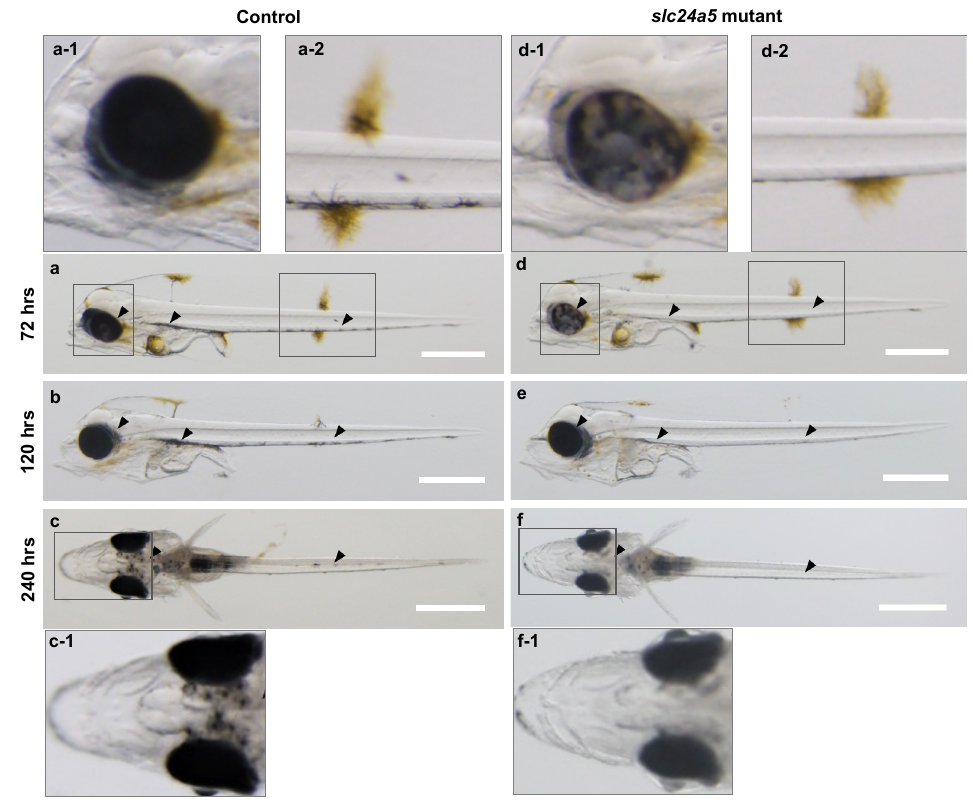
Figure 4. Representative images of kawakawa, Euthynnus affinis . Control larva ( a – c ) and slc24a5 mutant ( d – f ) at 72, 120, and 240 h post fertilization (hpf), respectively. Lateral ( a , b , d , e ) and dorsal views ( c , f ) are shown. The regions shown in ( a , d ), are enlarged in ( a-1 , a-2 ) and ( d-1 , d-2 ), respectively, while regions shown in ( c , f ) are enlarged in ( c-1 ) and (f-1 ) respectively. In intact larvae, melanin pigmentations were clearly observed at the eyes and ventral side of body at 72 hpf and on the dorsal side of head at 240 hpf. In the slc24a5 mutant, a mosaic pigmentation pattern was observed at 72 hpf and a lower level of pigmentation on the ventral side of body and head at 120 and 240 hpf. Pigmentation is shown by means of arrowheads. Scale: 1 mm.